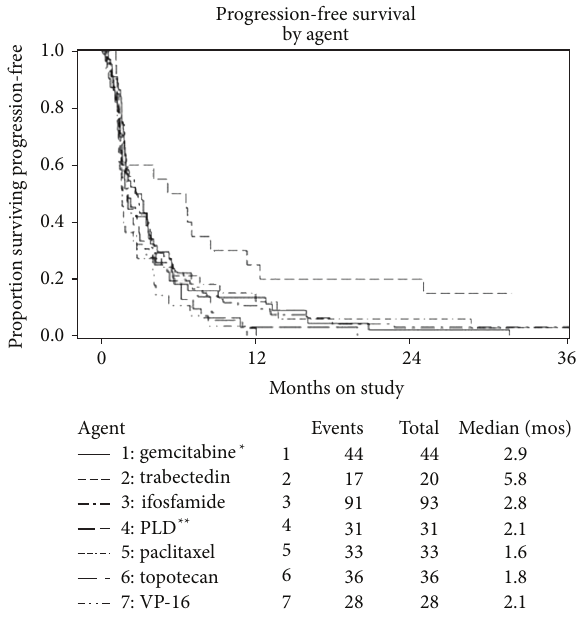
Figure 1: Kaplan–Meier plots demonstrating progression-free sur- vival (PFS) for the 20 patients in the study population (GOG 87M) comparedtoothersingleagentstudiesintheGOGprotocol87series studying cytotoxic agents. Reprinted from [49], with permission from